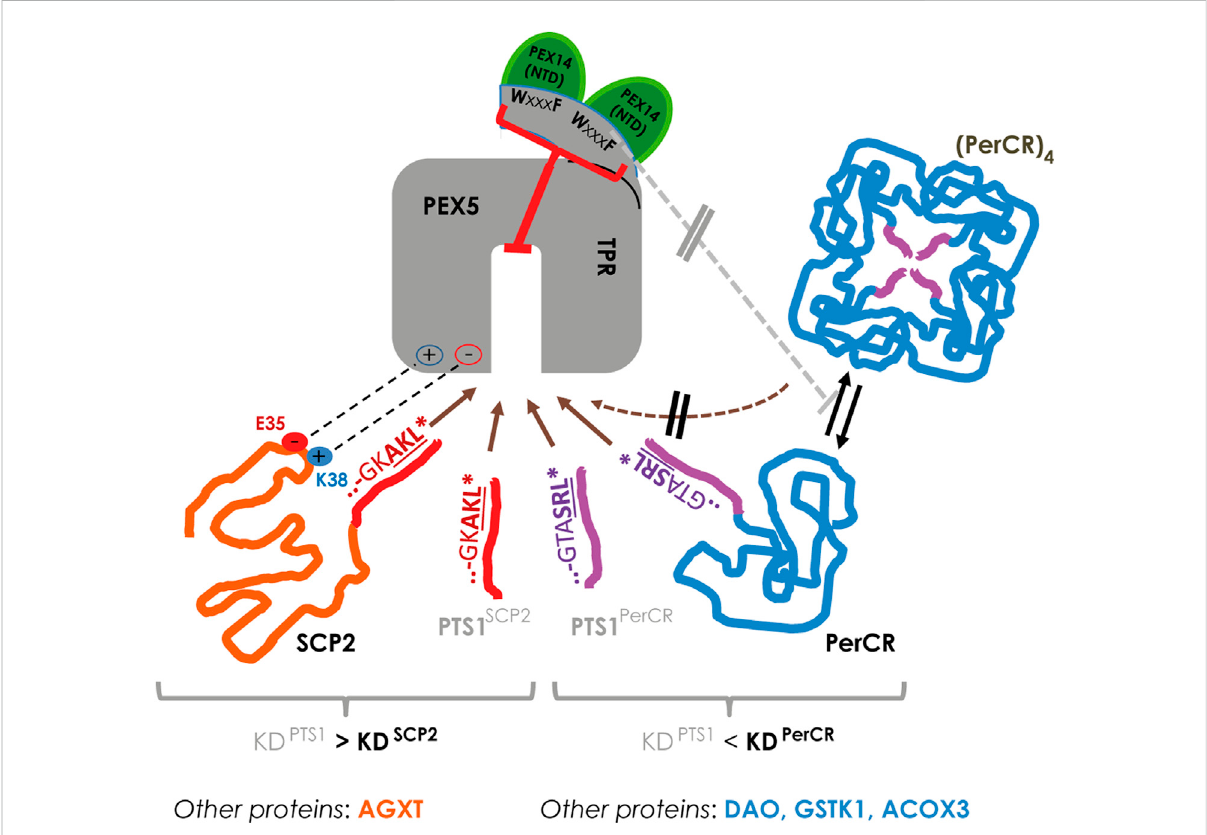
FIGURE 8 In living cells theinteraction strength between PEX5and its cargo proteinsis modulated atvarious levels: left : inSCP2the PTS1 binds PEX5with loweraf fi nitythanthefull-lengthproteinduetoanadditionalinteractiondomain(involvingE35andK38ofSCP2),whichmayalsoapplyfortheAGXT; right : in other proteins such as PerCR the interaction strength appears lower than the isolated PTS1, which is also observed for DAO, GSTK1 and ACOX3; in PerCR the PTS1 is inside the tetramer and thus not accessible to PEX5; thus, PerCR tetramers ((PerCR) 4 ) cannot bind PEX5